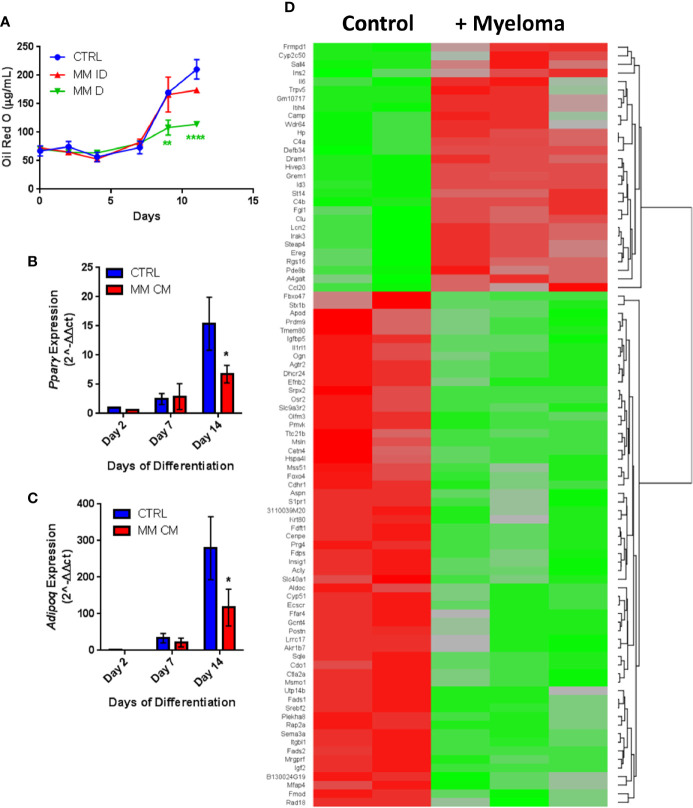
Adipogenic differentiation of 3T3-L1 preadipocytes is inhibited by MM.1S myeloma cells. 3T3-L1 adipocytes were assessed for Oil Red-O content either alone (control) or with exposure to MM.1S cells prior to differentiation process via indirect (+MM ID) or direct (+ MM D) co-culture (day 11). Lipid content is significantly reduced by MM.1S co-culture (indirect, MM ID; direct, MM D) during differentiation compared to 3T3-L1 cells on their own (CTRL); quantification of Oil Red-O staining (A). Expression of adipogenic transcripts Pparg
(B) and Adipoq
(C) are suppressed during differentiation in the presence of conditioned media from MM.1S cells; n=4. Significant differences in gene expression (p ≤ 0.05, FC |1.8|, red is upregulated, green is downregulated) in 3T3-L1 adipocytes exposed to myeloma cells for 48-h prior to differentiation as measured by microarray (D); control n=2, MM.1S n=3; *p < 0.05, **p < 0.01, ****p < 0.0001.